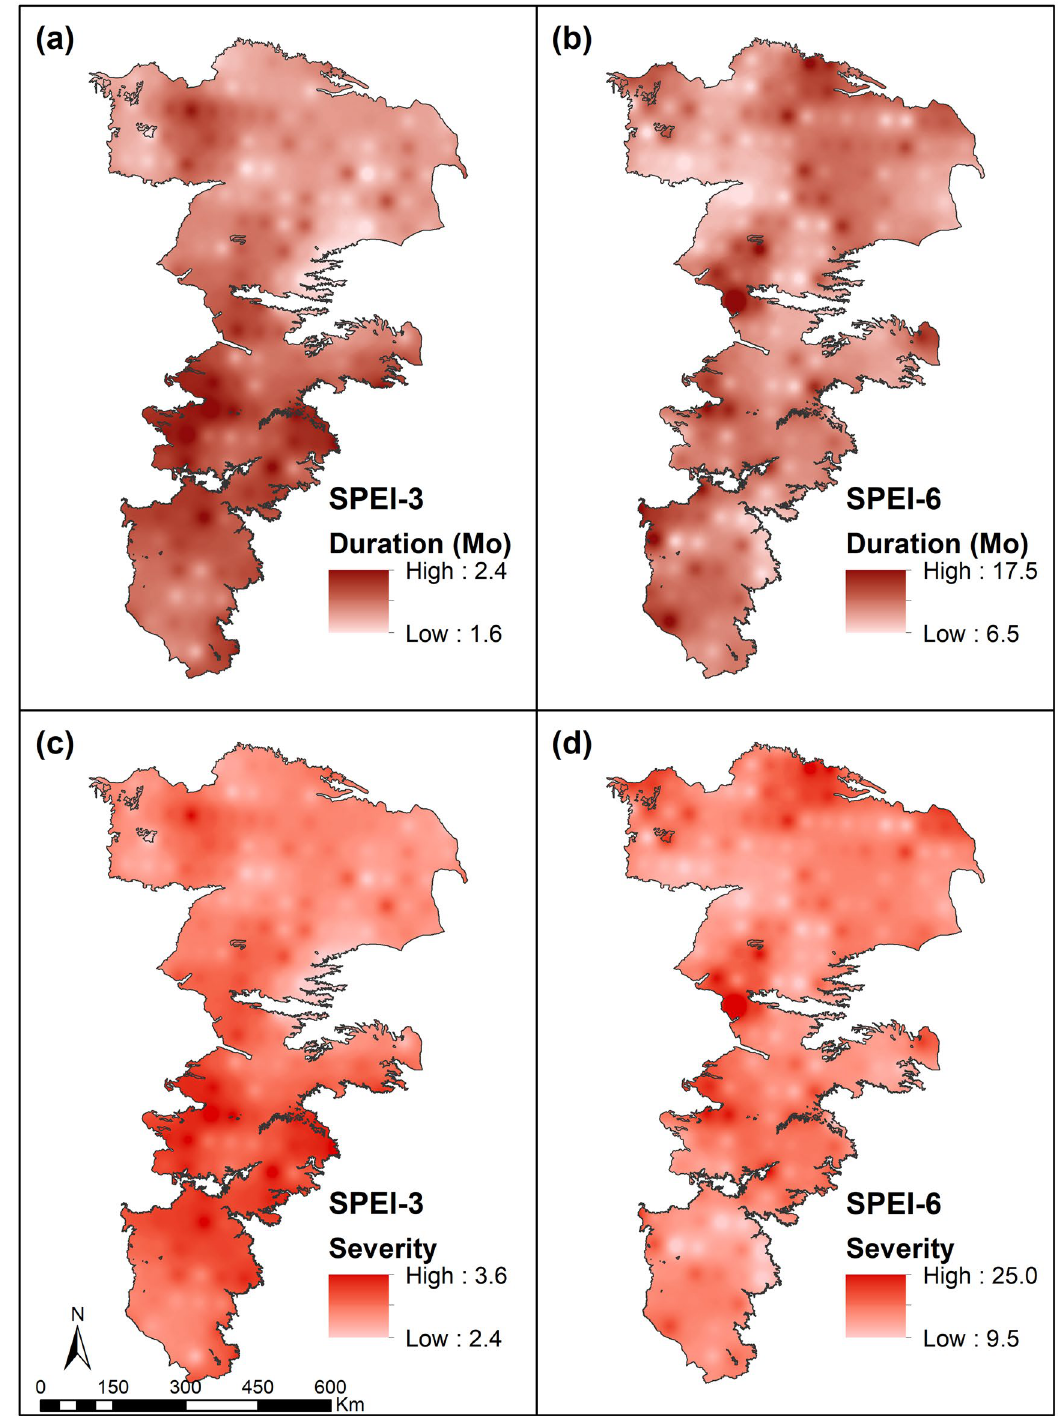
Figure 5. Expected values of the absolute drought severity and drought duration for SPEI at 3-month and 6-month